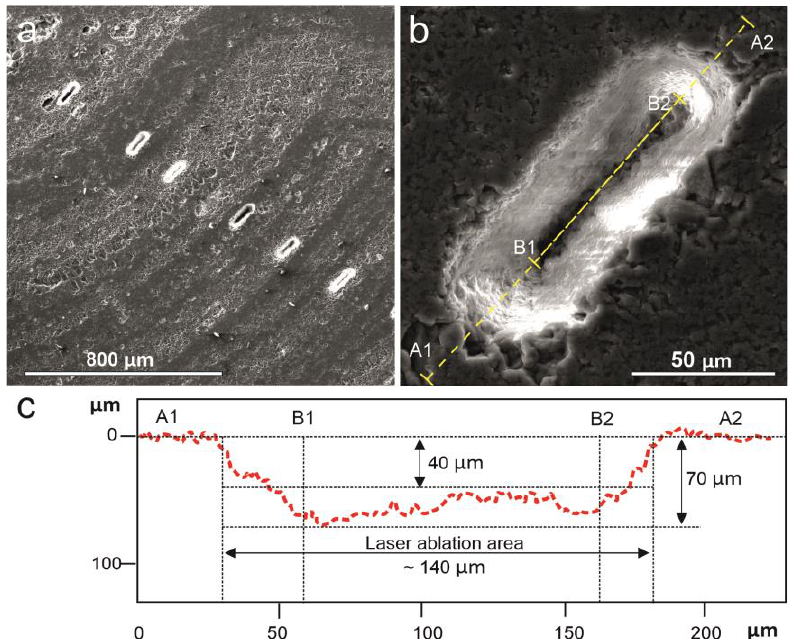
Figure 3. Surface topography of Onega agate samples and laser ablation (LA) crater character: ( a ) BSE image of laser sampling points in banding agate (#SvE-A1, Pinguba); ( b ) BSE image of the typical crater produced with 3 successive laser shots; ( c ) relief profile of ablation crater.